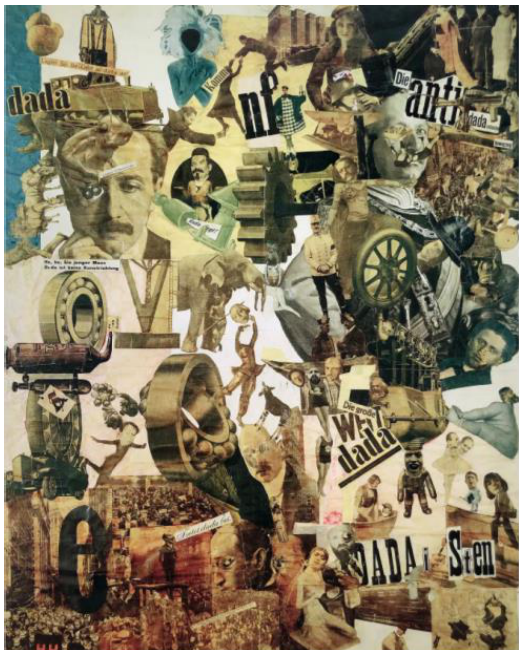
Figure 1. Image montage (source: [27]).